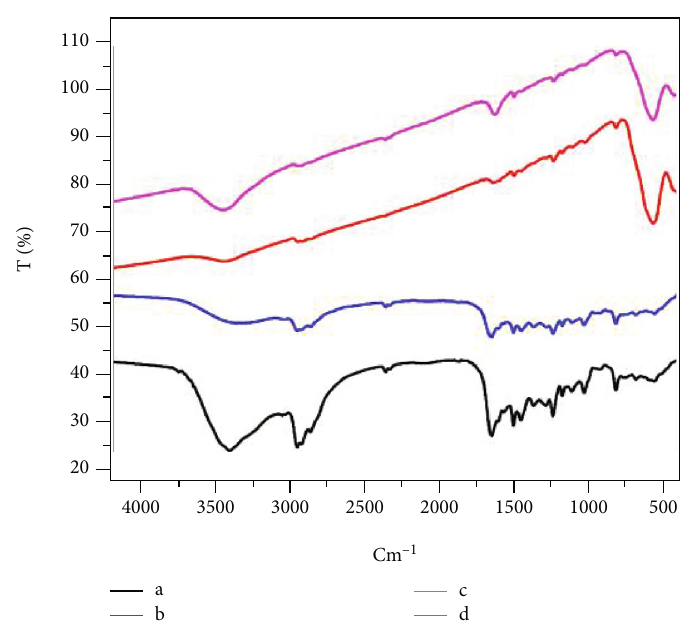
Figure 3: FTIR spectra of (a) NTEPA, (b) NDETA, (c) NTEPA/Fe